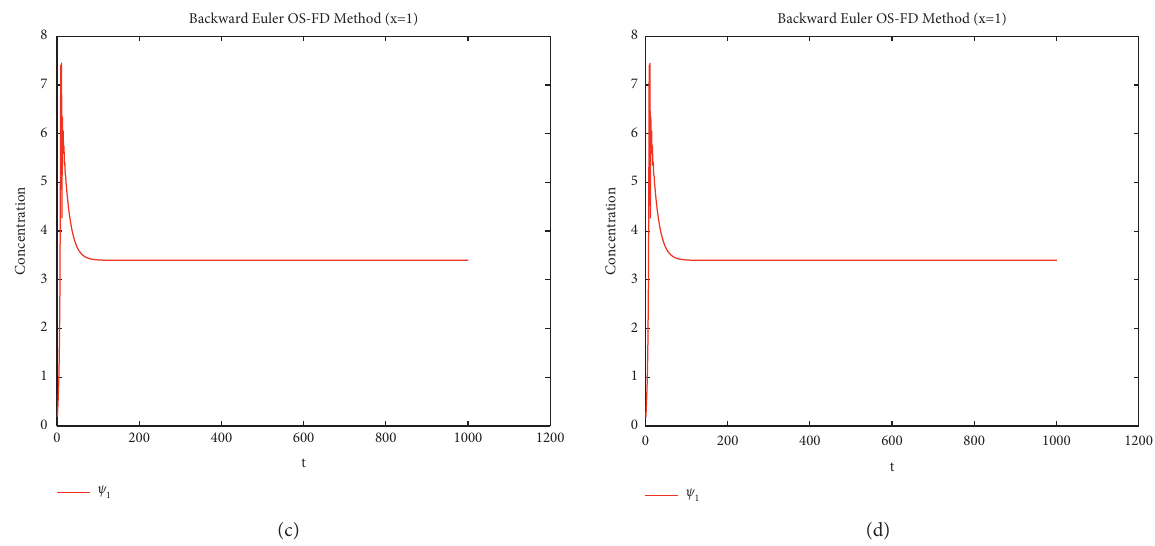
Figure 3: Solution graphs and plot graphs of ψ � 1 , ϑ � 3 . 4 , λ � λ � 0 . 0006 , and ε κ � 0 . 1 , ϑ 1 2 1 2 (d) Plot graph of ψ . 2